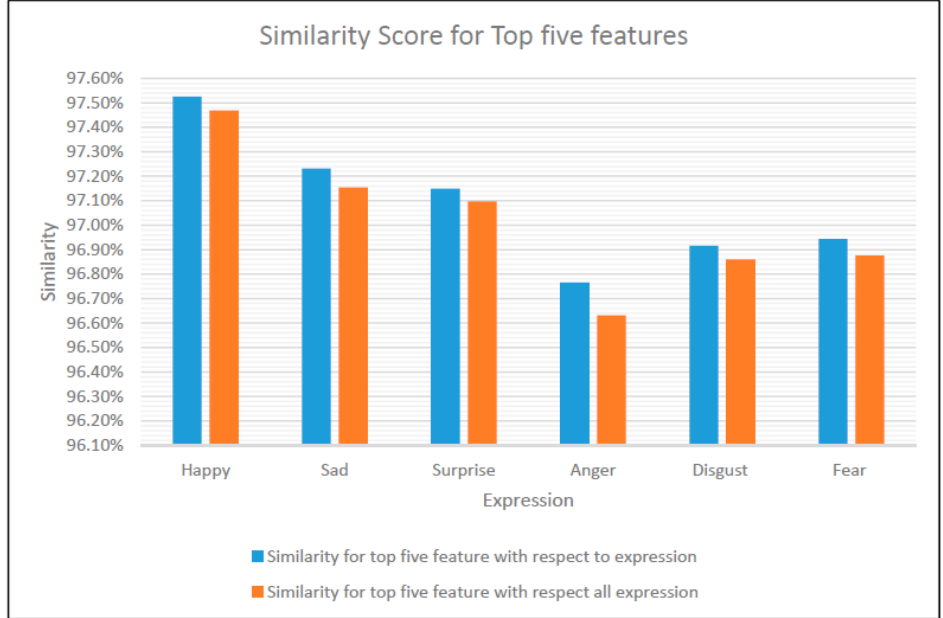
Figure 24. SS for top five features with respect to each expression vs. all expressions.